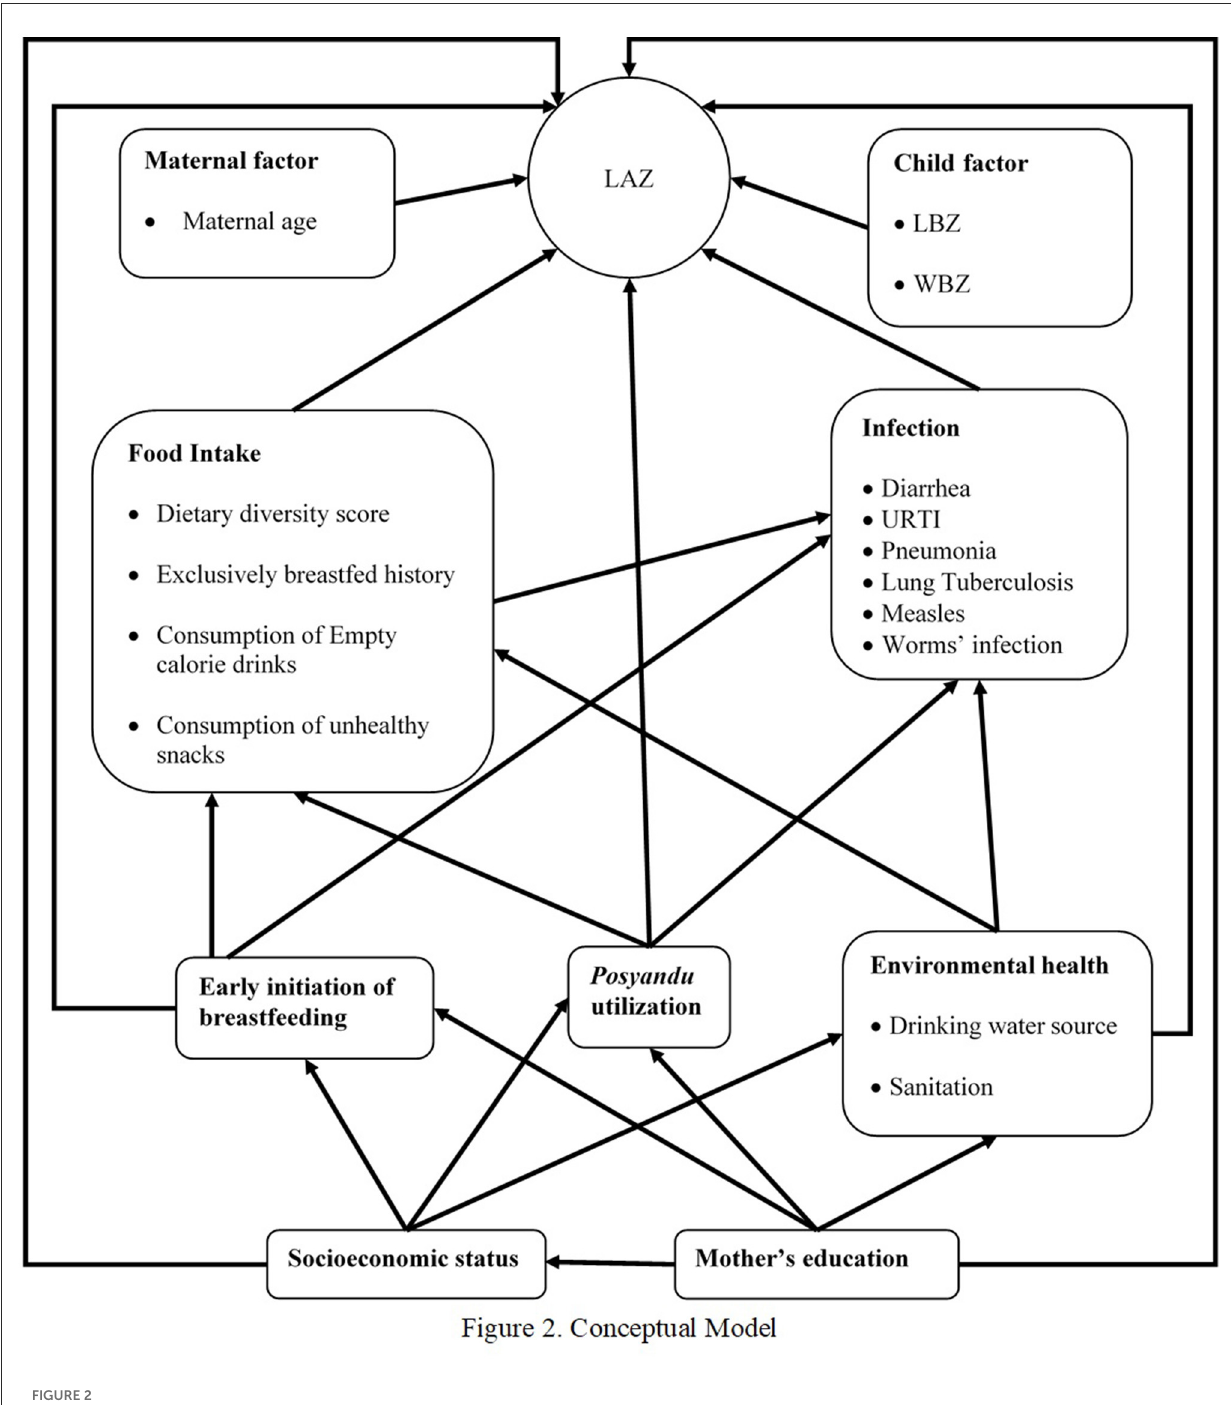
FIGURE2 Conceptual model.